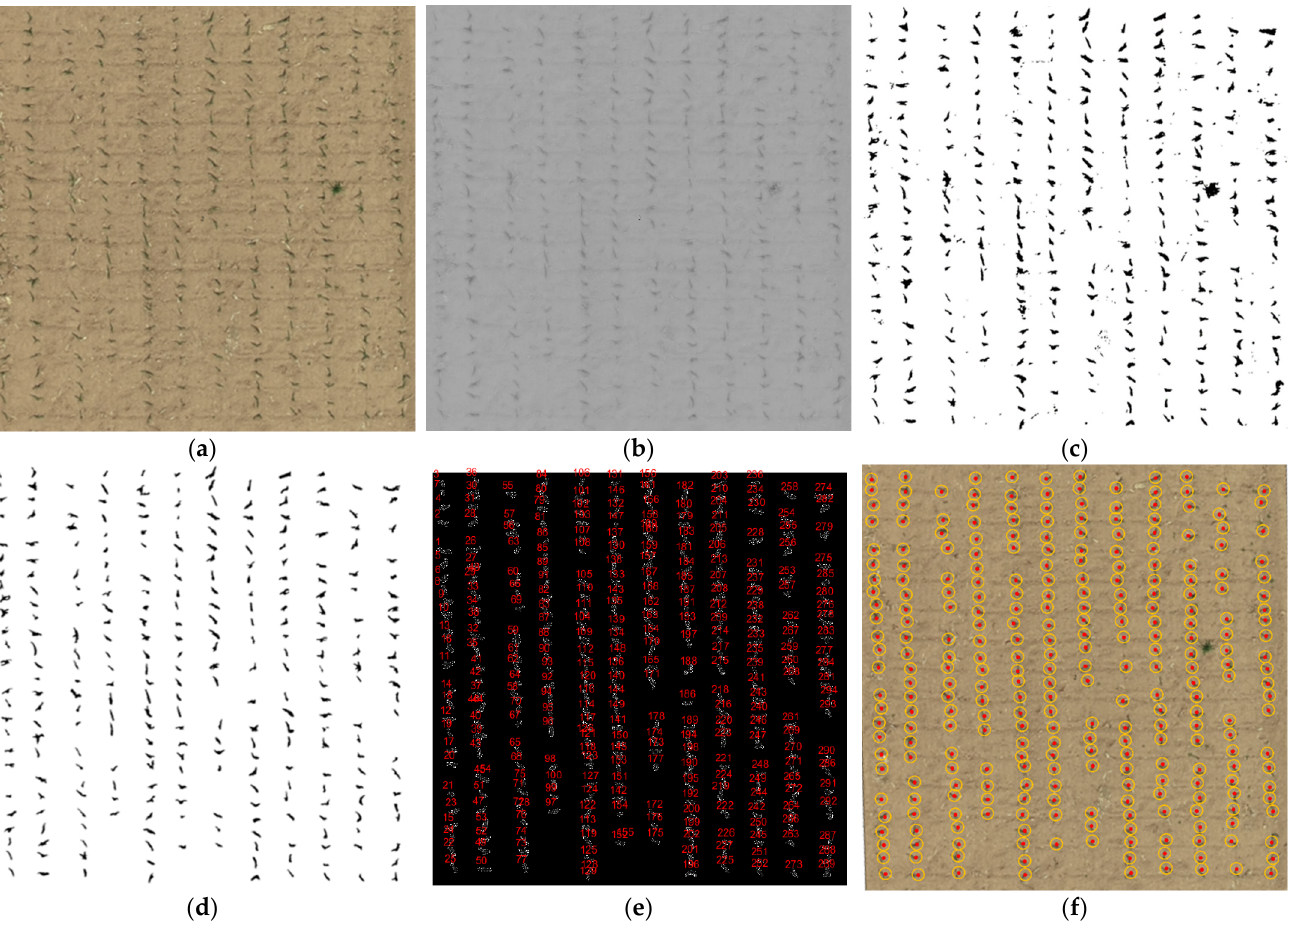
Figure 11. Extraction of seed point set: ( a ) orthophoto, ( b ) image processed by color space conversion, ( c ) the results map of extra-detection, ( d ) seedlings region, ( e ) the number of seedlings, ( f ) seed point set.